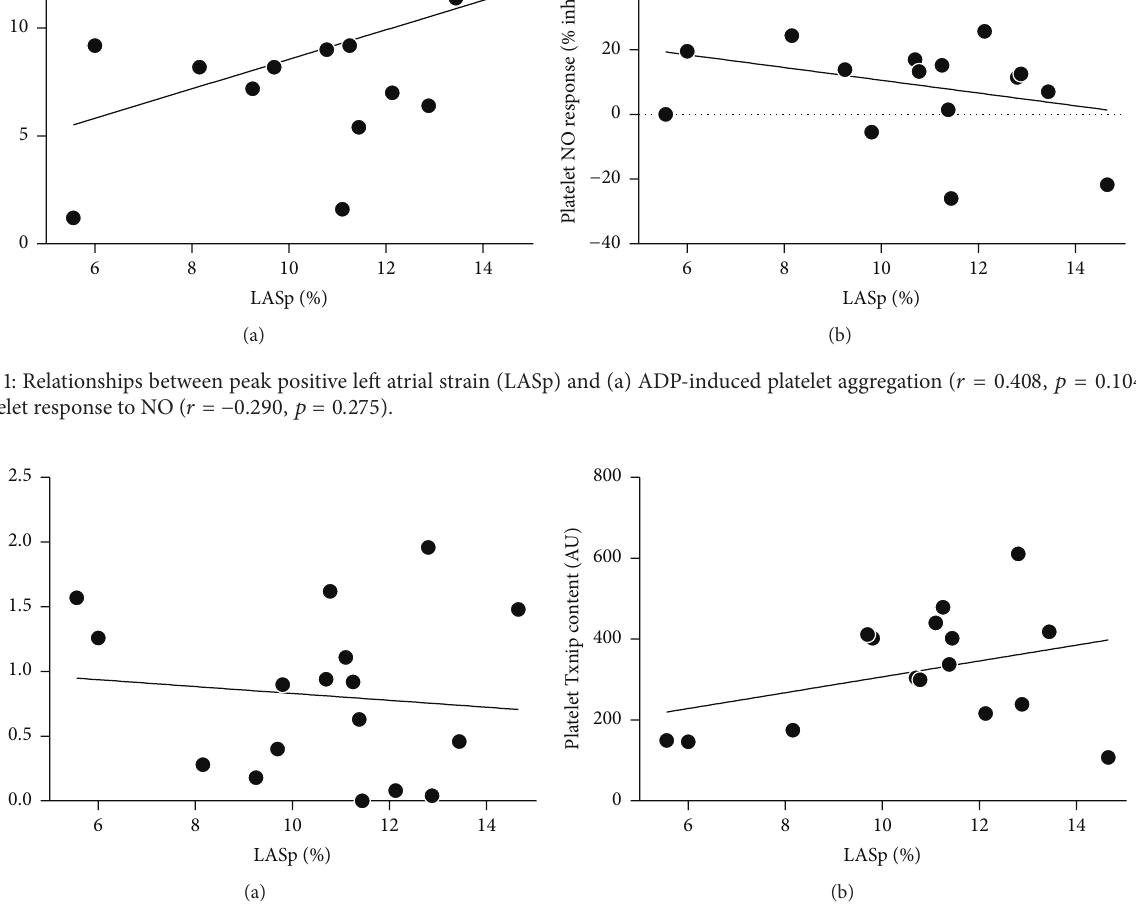
Figure 2: No significant correlation was observed between LASp and (a) plasma CRP concentrations ( 𝑟 = −0.105 , 𝑝 = 0.689 ) or (b) platelet Txnip content ( 𝑟 = 0.345 , 𝑝 = 0.191